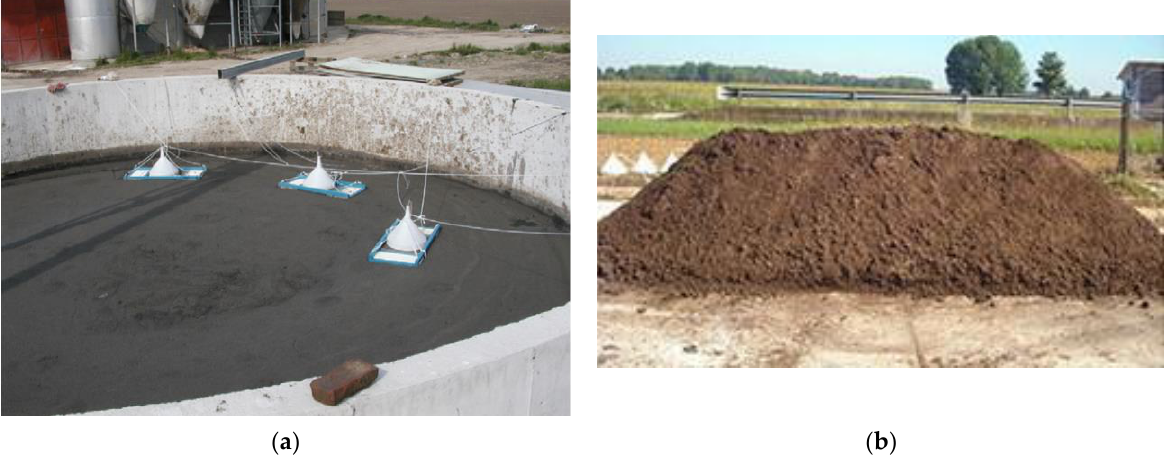
Figure 8. ( a ) Surface area of the liquid pig slurry (3.9% TS) in an open storage pond [151]. Reprinted with the permission of Biosystems Engineering (Elsevier). ( b ) Surface area of dewatered pig slurry (65.4% TS after composting without a bulking agent) [152]. Reprinted with the permission of Powder Technology (Elsevier).